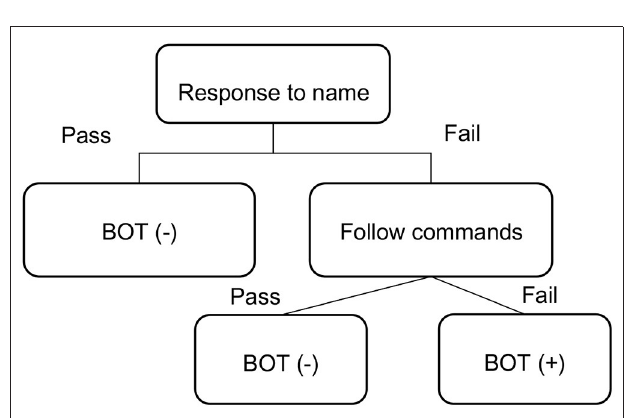
FIGURE 2 | Procedure of the binomial observational test (BOT).